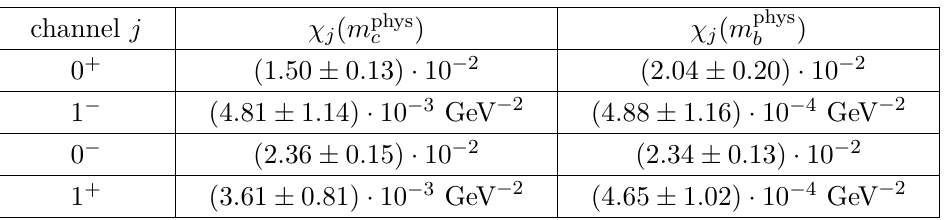
Table 7 . Values of the longitudinal and transverse, vector and axial-vector susceptibilities evaluated in this work at the physical c - and b -quark points after extrapolation to the physical pion point and to the continuum and infinite volume